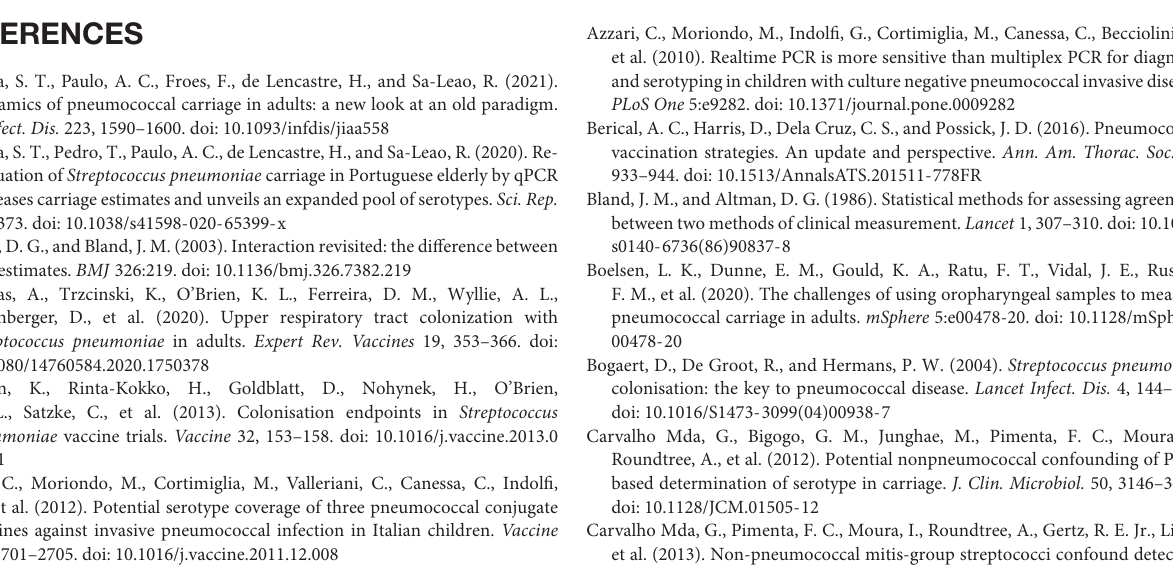
Supplementary Figure 1 | Results of molecular method-based quantification of serogroups/serotypes-specific sequences in DNA from culture-enriched nasopharyngeal and oropharyngeal samples. Individual scatter plots depict results of a single serotype-specific or serogroup-specific qPCR assay as labeled above the panel. Each symbol represents an individual sample: pale-red dots represent nasopharyngeal samples from children; blue triangles and green triangles represent nasopharyngeal and oropharyngeal samples from adults, respectively. Sample was classified as positive for a serotype/serogroup with molecular method when the signal detected by qPCR for piaB ( X -axis) and serotype/serogroup ( Y -axis) were both below the ROCd C q cut-off threshold of 30 C q . Only samples that generated a signal of C q < 40 in a particular serogroup/serotype-specific qPCR are depicted. Symbols of C q > 40 for piaB depict individual samples or pools of samples negative for pneumococcus by qPCR. In the panel depicting qPCR results for serogroup 6 all symbols represent samples identified as positive for serotypes 6C or 6D except for red circles depicting two samples identified as positive for serotype 6A or 6B, both positive for serotype 6A by culture. In the panel depicting qPCR results for serogroup 22 all symbols represent positivity for serotype 22F. None of the samples generated any signal in qPCRs targeting serotype 1, serotype 23F and serogroup 18. In addition, no samples were identified as positive for serogroup 12 according to study criteria. Supplementary Figure 2 | Scatter plot displaying correlation between cycle threshold (C q ) from real-time PCR (qPCR) assays targeting the Streptococcus pneumoniae piaB and serotype/serogroup specific signal detected with qPCR for culture-enriched (CE) oropharyngeal samples from adults classified positive for S. pneumoniae according to ROCd C q criterium (green dashed lines). Dots depicts serotypes detected with qPCR. Dots are color-coded according to serotypes/serogroup targeted in an assay (see